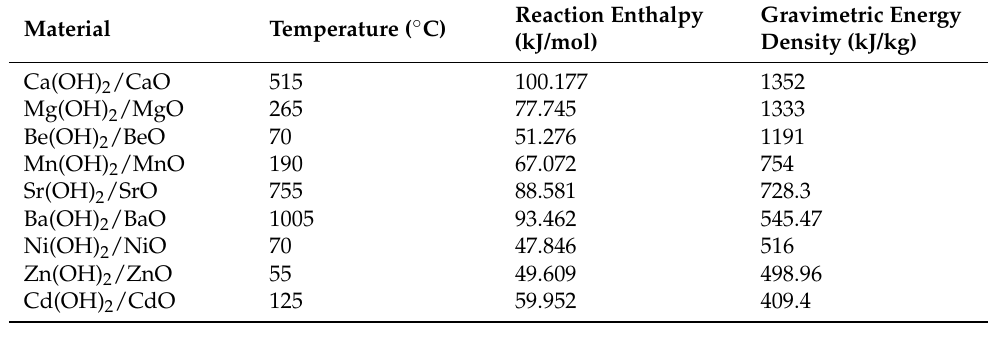
Table 3. Equilibrium temperature and heat storage capacity of metal hydroxides [11].